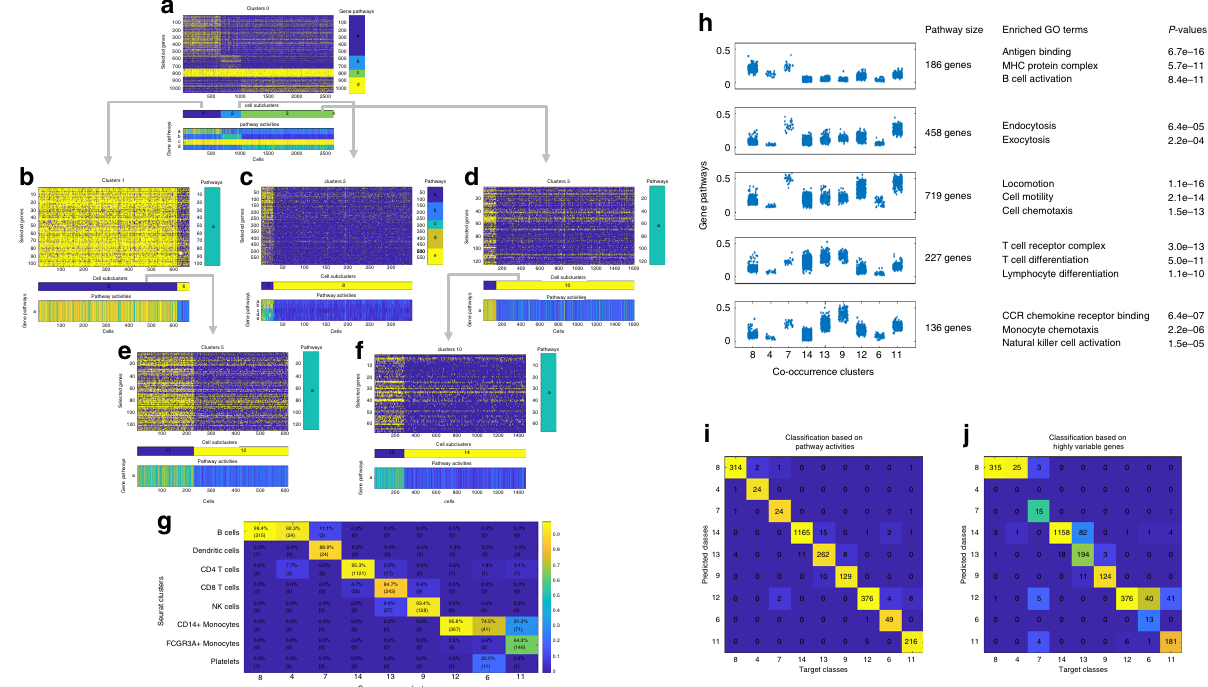
Fig. 2 Co-occurrence clustering applied to dropout pattern in PBMC data. a – g Gene pathways and cell clusters identi fi ed in each iteration of the co- occurrence clustering algorithm. h Comparison between co-occurrence clusters and Seurat clusters on this dataset. i Pathway activities and enriched GO terms. Enrichment is evaluated by one-sided hypergeometric test on the overlap between identi fi ed pathways and GO gene sets provided by MSigDB. The reported p -values are unadjusted. j , k Random Forest classi fi cation and 5-fold cross-validation of the co-occurrence clusters based on pathway activities and highly variable